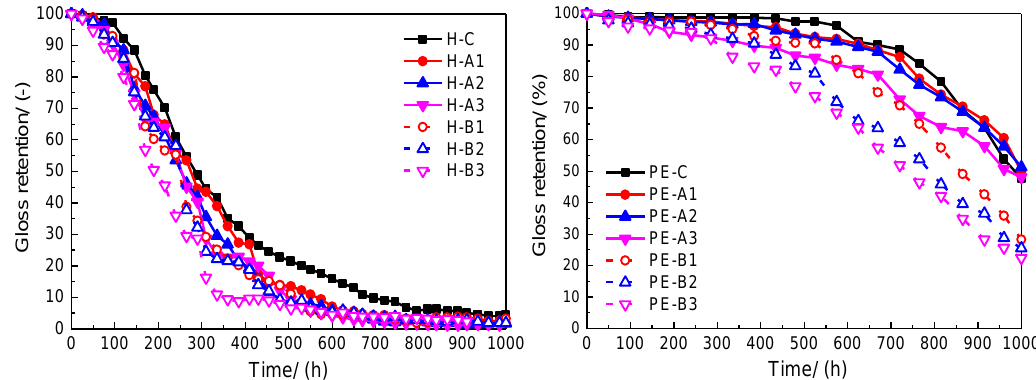
Figure 12. Gloss retention of samples after 1000 h of UV accelerate test.